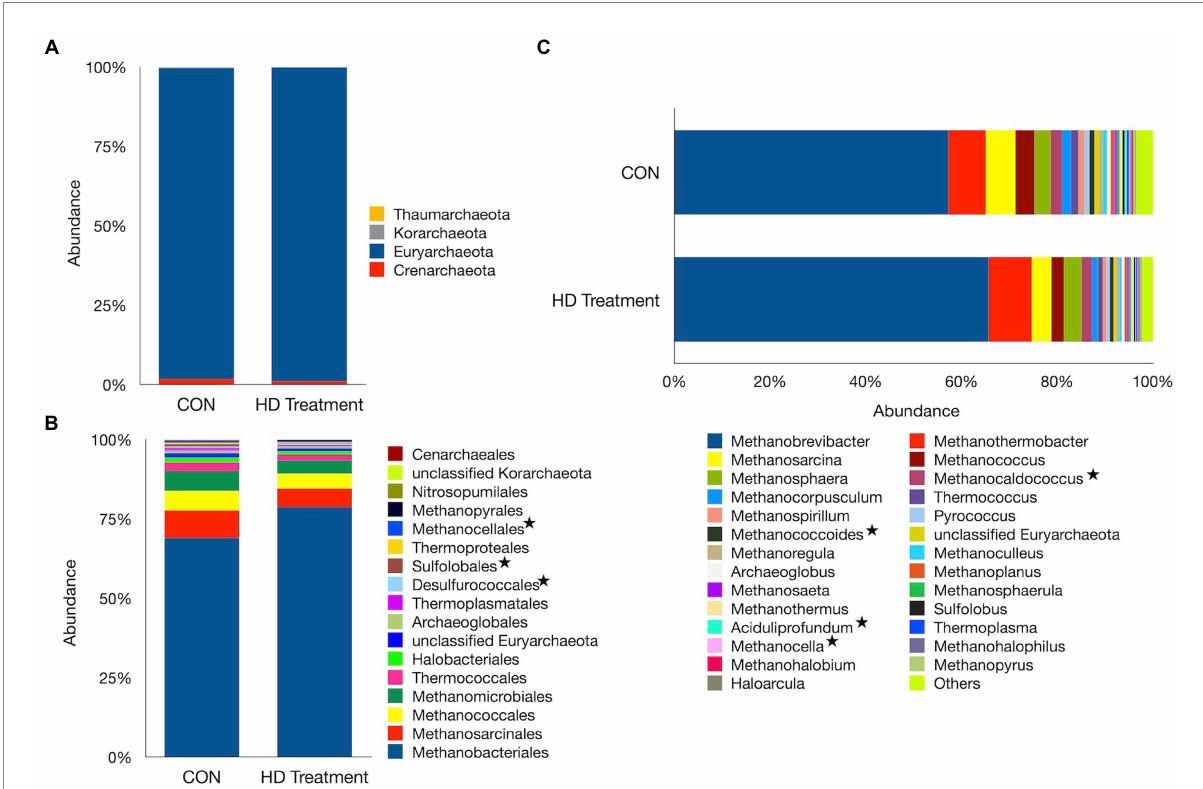
FIGURE 3 Archaeal profiles at different phylogenetic levels. Bar graphs illustrate the relative abundances of archaeal taxa at the phylum (A) , order (B) , and genus (C) levels. In the plots, the category “Others” represents taxa with relative abundances of <1%. Asterisks denote taxa that differ in abundance between the CON and the HD treatment